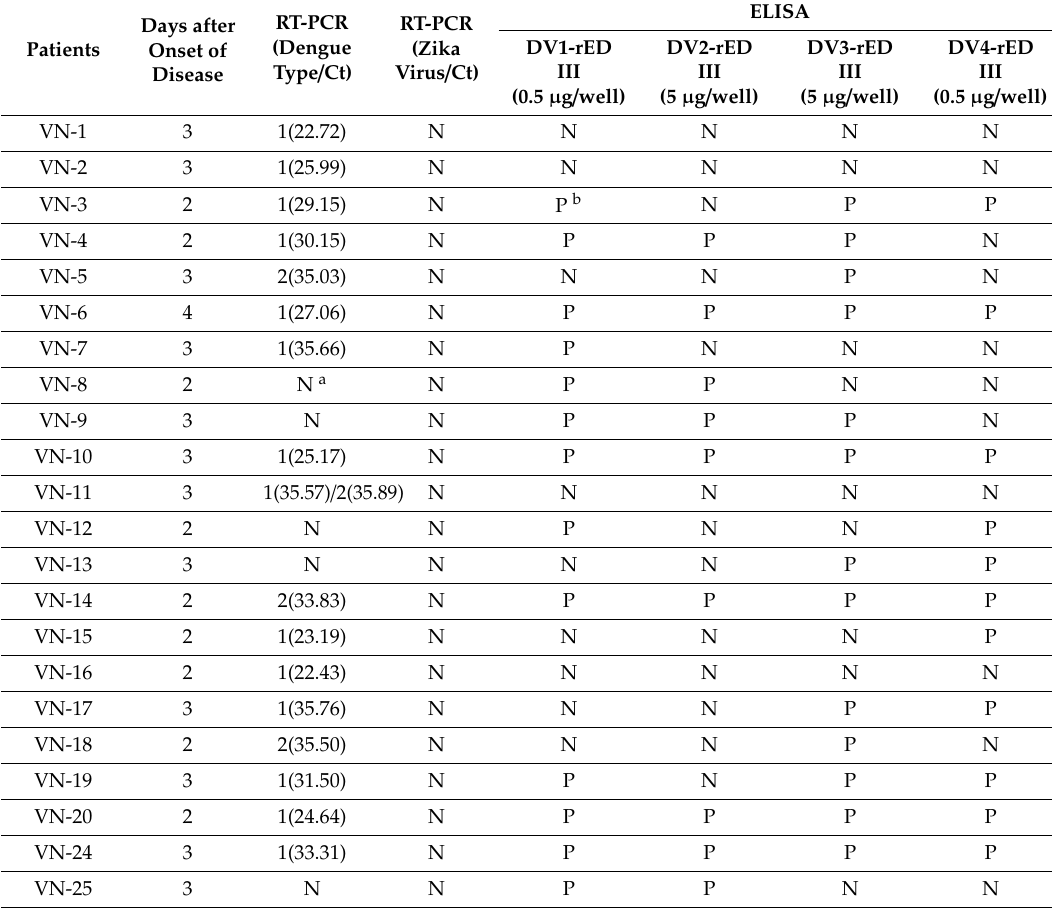
Table 3. Diagnostic performance of antigen-linked ELISA using recombinant antigens under best condition.